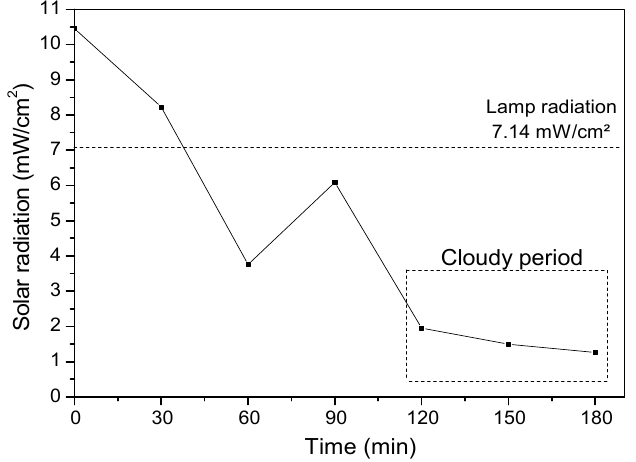
Figure 5. Artificial radiation and solar radiation irradiation intensity during experimental tests with industrial effluent. Table 2. Characterization of distilled water, synthetic effluent, and industrial effluent before and after the reactions.